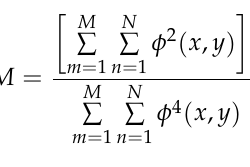
Figure 5. Target ratio of different velocities under three thresholds.